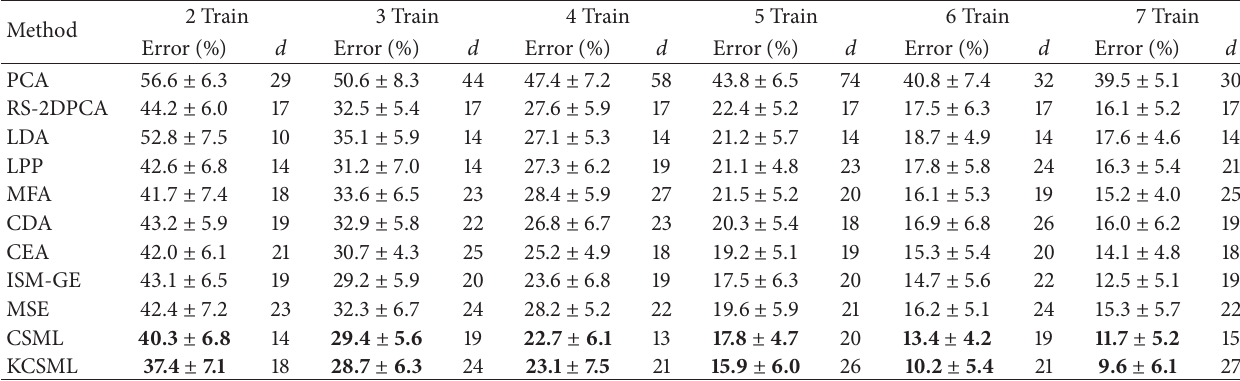
Table 2: Classification performance comparison on the Yale database.